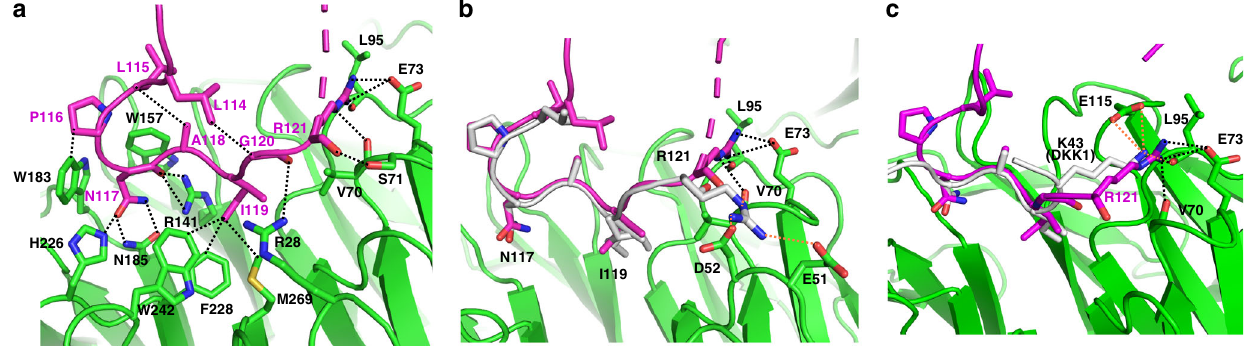
Fig. 2 Canonical binding site of SOST loop 2 in LRP6 E1. a Key interactions of the SOST loop 2 region with LRP6 E1 (within 4 Å) are shown with dotted lines. Interacting residues are presented as sticks and are labeled black for LRP6 or magenta for SOST. The missing region of SOST (residues 122 – 127) in this structure is represented with a dashed line. b Comparison of the SOST loop 2 binding site in our structure with that of the LRP6 E1 – SOST peptide complex structure (PDB ID: 3SOV) is presented. The SOST “ LPNAIGR ” peptide is shown in light gray, and LRP6 E1 from PDB 3SOV is omitted for clarity. The interactions of the NXI motif were found to be conserved in both structures, although the R121-mediated interactions differed. The interactions of R121 in the LRP6 E1-peptide structure are represented with orange dotted lines. c Structural comparison with the LRP6 E1 – DKK1 peptide (NSNAIKN) complex (PDB ID: 3SOQ) is shown. The DKK1 peptide is colored in light gray. The interactions of K43 in the LRP6 E1 – DKK1 peptide structure are represented in orange dotted lines.